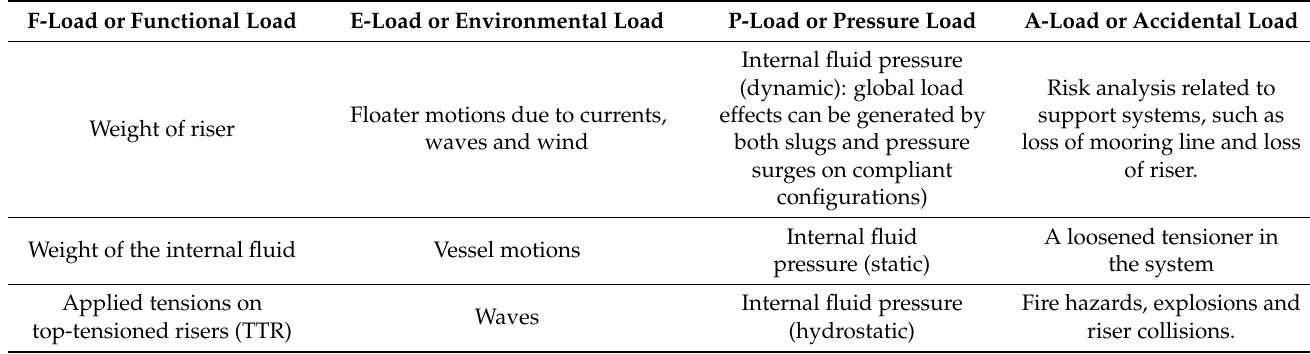
Figure 9. Depiction of composite riser system with loads, layers and cross-sectional cut. Table 2. Different types of loads (Sources: DNV-OS-F201; 2010 and API RP